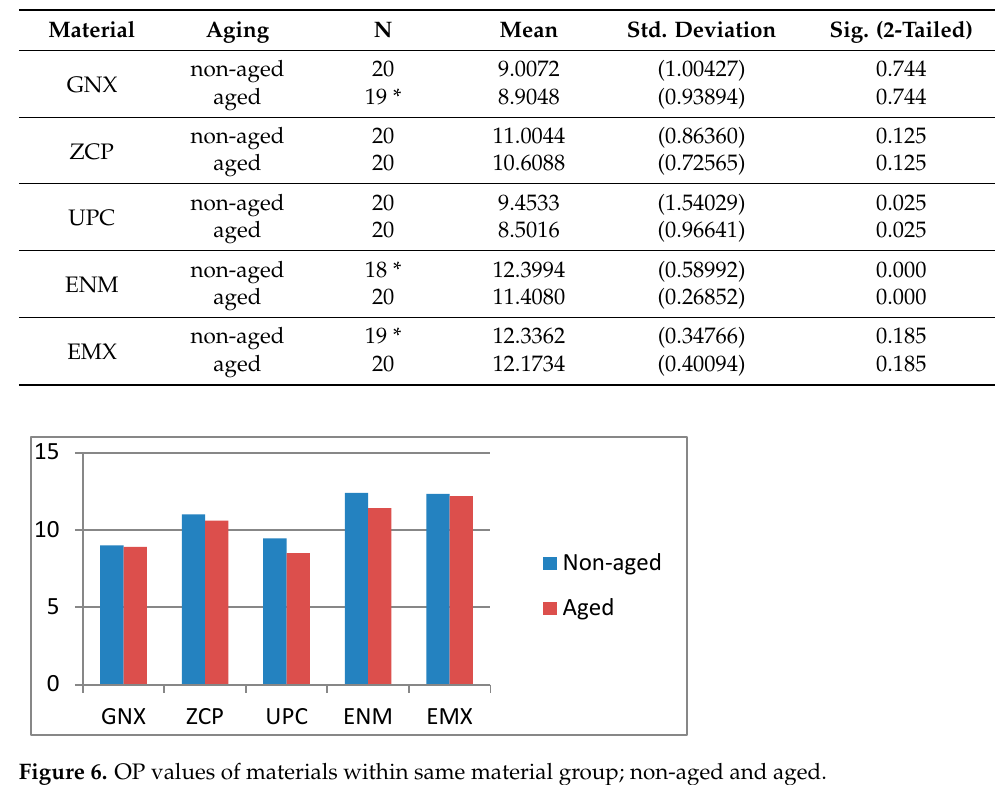
Table 14. Comparison of OP values within same material group; non-aged and aged. Shaded cells indicate significant differences p < 0.5. * Outliers were deleted.